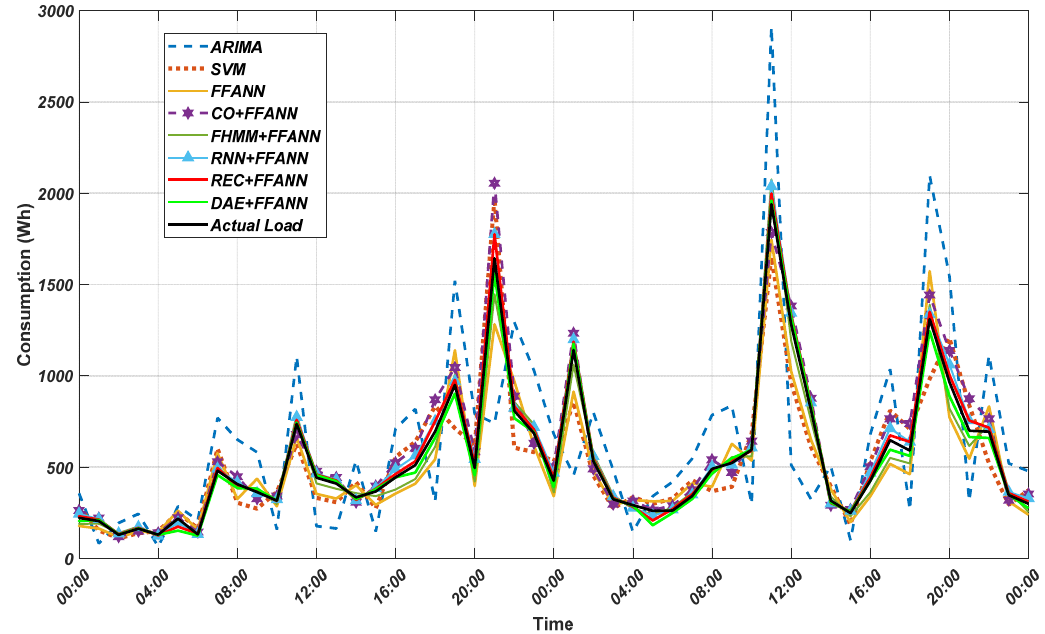
Figure 9. The actual and forecasted load by different methods for the home seen during the ED training.